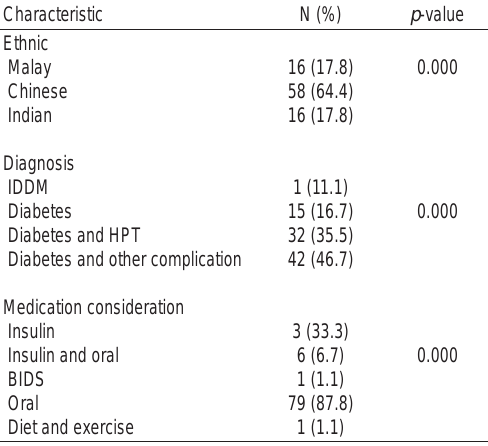
TABLE 7. Characteristic determination of RF5-Male>45 years (N=114/150) among male in study population